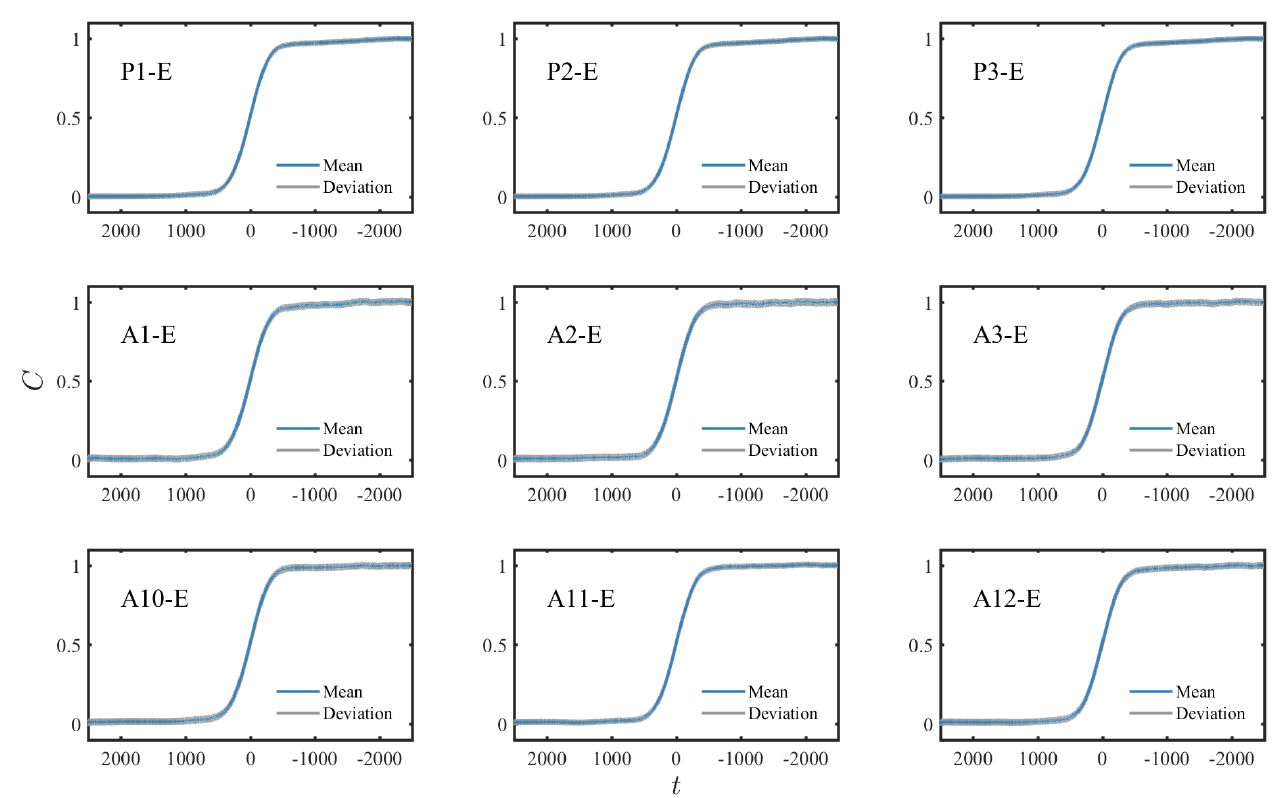
Figure 6. Experimental error estimate for five repeated runs. The blue curve is the mean of the experiments and the gray curve is the average